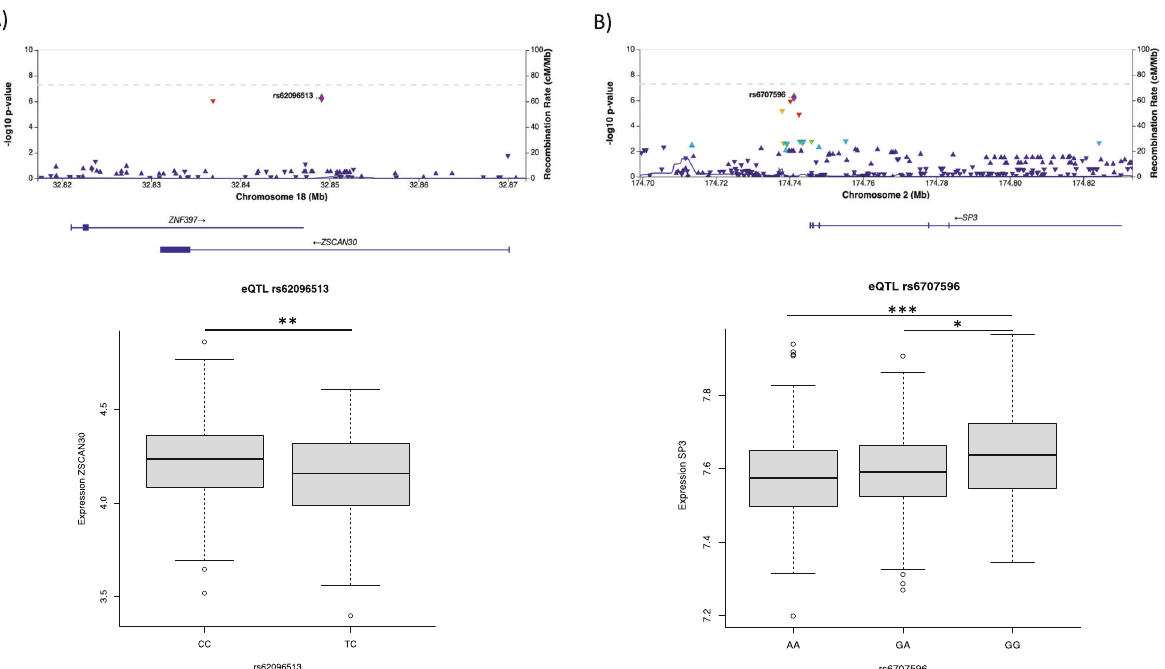
Fig. 3 Regional plots and cis-eQTL analyses in PBMCs in our in-house sample of 270 ADHD cases and 279 controls. In the top fi gure, regional plots for module eigengenes for the ( A ) rs62096513 and ( B ) rs6707596 loci and in the bottom fi gure, boxplots showing the effect of rs62096513 in ZSCAN30 and rs6707596 in SP3 gene expression. Results from the linear regression p -value are shown: * P < 0.5, ** P < 0.01, *** P <